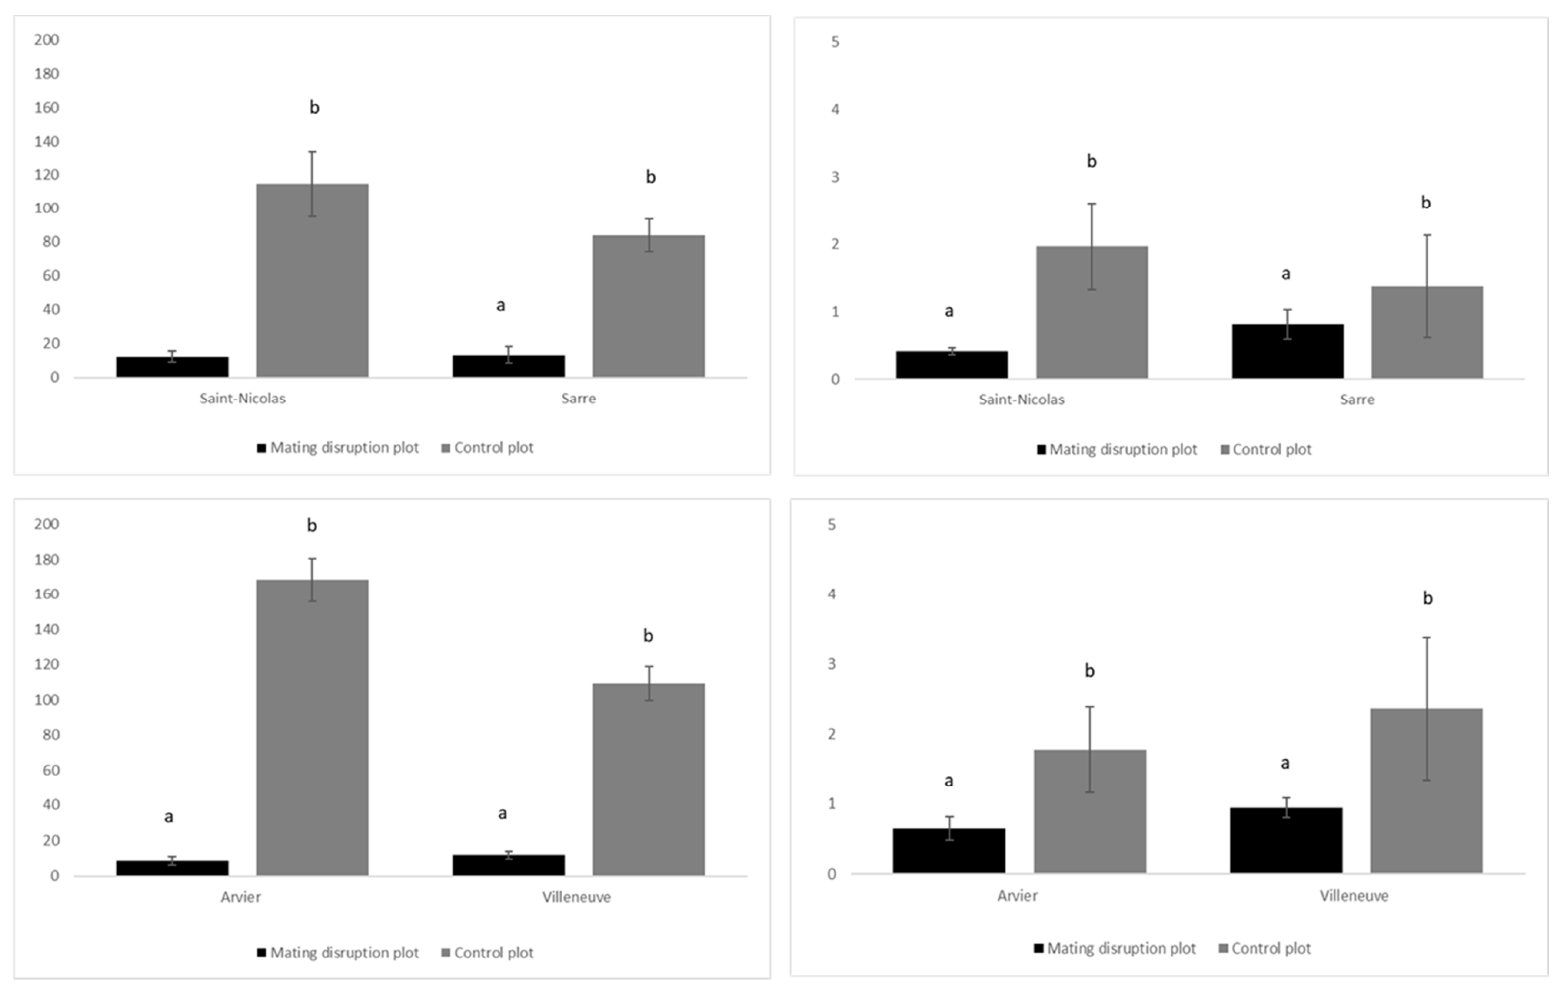
Figure 4. Mean number (± SEM) of male adults/per trap/per week of Thaumetopoea pityocampa collected with pheromone-baited traps, and mean number (± SEM) of nests/tree recorded in plots where mating disruption (MD) was applied compared to control plots in 2016 (top) and 2017 (bottom). Bars with different letters are significantly different, according to the paired t -test ( p < 0.05).